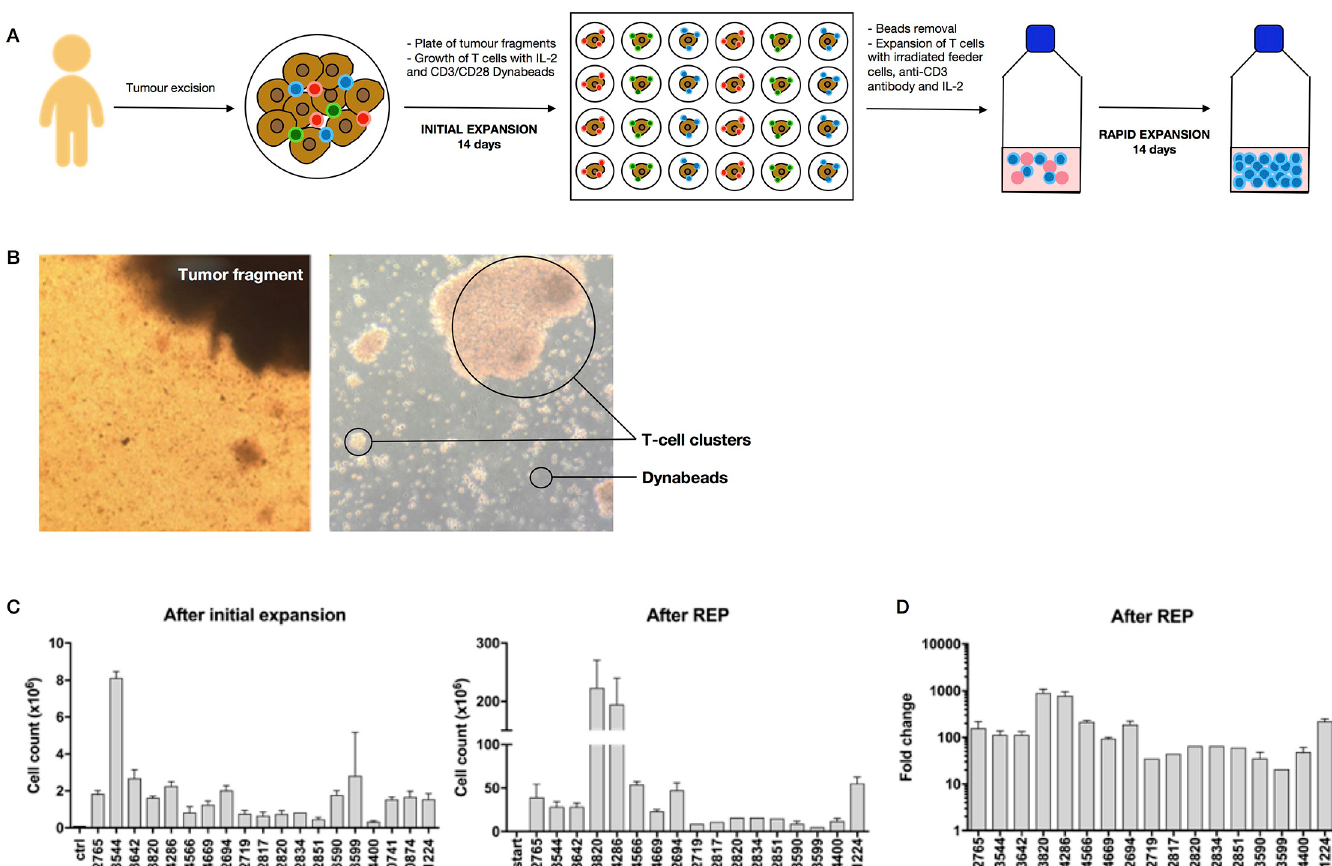
Fig 1. Large numbers of TILs can be expanded from neuroblastoma samples. (A) Overview of TILs expansion protocol. (B) Representative microscope images of TILs at day 14 of initial expansion (left), and TILs at the end of REP (right). (C) Cell count per well at the end of initial expansion (left) and cell count per 75cm 2 flask at the end of REP (right). D) Fold change after REP. Data represented as mean ± Standard Error of Mean (SEM). Each case comprised a mean of 7.3 fragments (range 1–30 n = 19) for initial expansion and mean of 3 (range 1–8 n = 17) independent cultures per case for REP. Note case 1224 is the average of 4 independent tumors from the same patient. Accurate cell counts were missing from 4 further cases that went on to